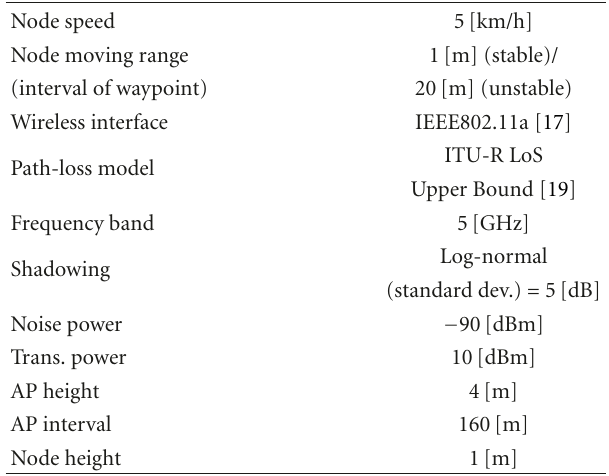
Table 2: Simulation parameters in wireless-channel